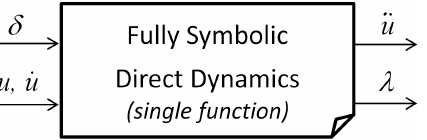
Figure 9. Closed-loop MBS: fully symbolic generation of the direct dynamics.